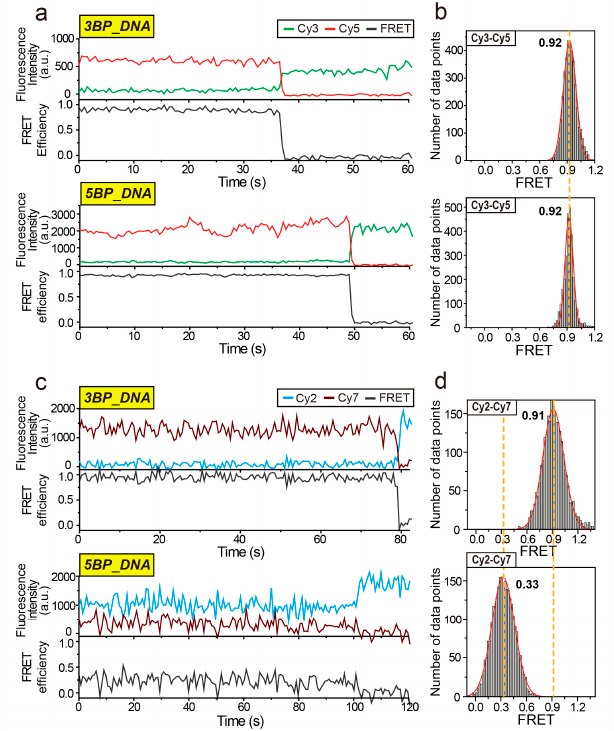
Figure 3. Single-molecule FRET measurement in proof-of-concept experiments using the double-stranded DNA constructs. ( a ) Representative time traces of Cy3 (green) and Cy5 (red) fluorescence, and the corresponding FRET efficiency (gray) for 3BP_DNA (upper graph) and 5BP_DNA (lower graph) constructs. ( b ) FRET histograms of the Cy3–Cy5 pair for 3BP_DNA (upper graph) and 5BP_DNA (lower graph). Average FRET efficiencies of the Cy3–Cy5 pair for the two DNA constructs were obtained by fitting the FRET histogram to a single Gaussian function. ( c ) Representative time traces of Cy2 (blue) and Cy7 (purple) fluorescence, and the corresponding FRET efficiency (gray) for 3BP_DNA (upper graph) and 5BP_DNA (lower graph) constructs. ( d ) FRET histograms of the Cy2–Cy7 pair for 3BP_DNA (upper graph) and 5BP_DNA (lower graph). Average FRET efficiencies of the Cy2–Cy7 pair for the two DNA constructs were obtained by fitting the FRET histogram to a single Gaussian function. FRET histograms were obtained by taking the FRET efficiency of 10 s for each molecule out of more than 100 molecules, except photobleaching events. The single-step intensity drop of the acceptor and rise of the donor in the representative intensity traces demonstrate that the measured fluorescence signals are derived from a single donor and acceptor pair.